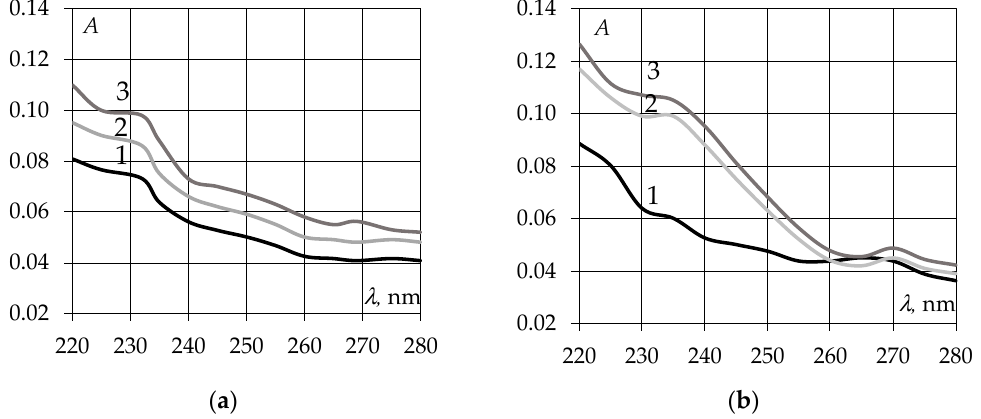
Figure 3. Changes in the UV spectra of 0.02% isooctane solutions at 232 nm and 268 nm during storage of EAGO ( a ) and sunflower oil ( b ) at a temperature of 20 ± 1 °C for: 1—0 days; 2—60 days and 3—100 days.